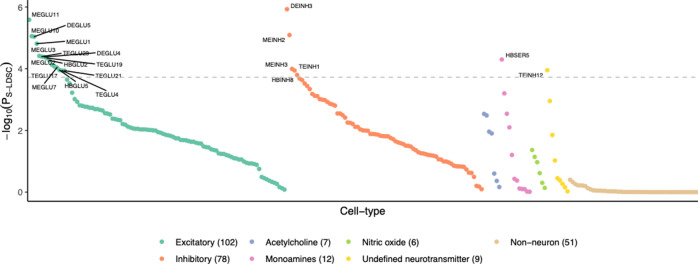
BMI-prioritized Mouse Nervous System cell type neurotransmitter classes BMI GWAS prioritized cell types prioritization enriched for neurons.Non-neuronal (glial and vascular) cells did not exhibit any genetic enrichment. Cell types are grouped by neurotransmitter type and ordered by BMI GWAS-enrichment p-value (PS-LDSC). The horizontal line marks the Bonferroni significance threshold (PS-LDSC <0.05/265).